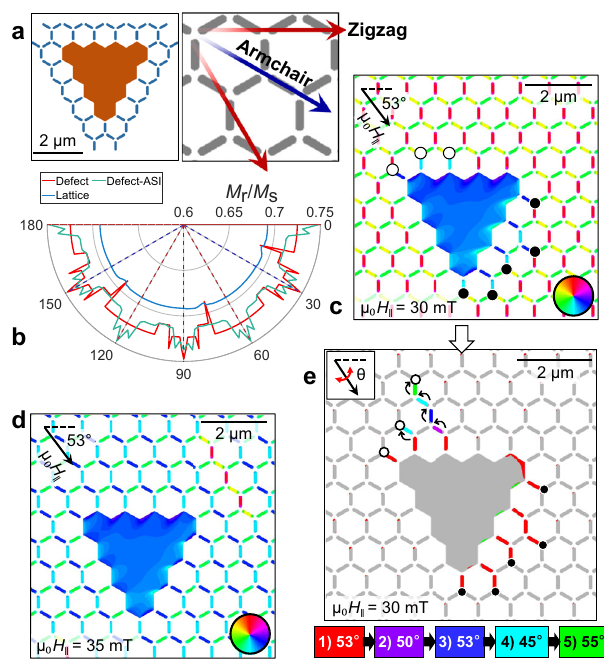
Fig. 4 Modeling of defect-induced MP propagation. a (Left panel) Small DASI lattice where individual defect and lattice components (orange and blue, respectively) are combined to form Defect-ASI; (Right panel) Schematic of zigzag and armchair axes (burgundy and navy-blue, respectively). b Angular dependence of the normalized remanent magnetization ( M r / M s ) of the lattice (blue), defect (red) and combined Defect-ASI (green) systems achieved by application of μ 0 H ‖ = 2 T saturation fi eld then subsequently left to evolve at remanence; dashed burgundy and navy-blue lines represent zigzag and armchair axes, respectively. c , Modeled magnetization con fi guration (color represents angle of the magnetic vector with respect to the x -axis) of the DASI lattice at µ 0 H || = 30 mT and θ = 53°, where nucleated monopoles are presented as black and white circles (positive and negative charges, respectively). d , Modeled magnetization map of the same lattice at µ 0 H || = 35 mT and θ = 53°, where most of the NIs along the fi eld-direction have switched. e , Differential map of modeled switching events, at µ 0 H || = 30 mT, as θ is varied within the range 45 – 55°, NI fl ips are colored according to the legend (e.g., red NIs represent the switched states from c